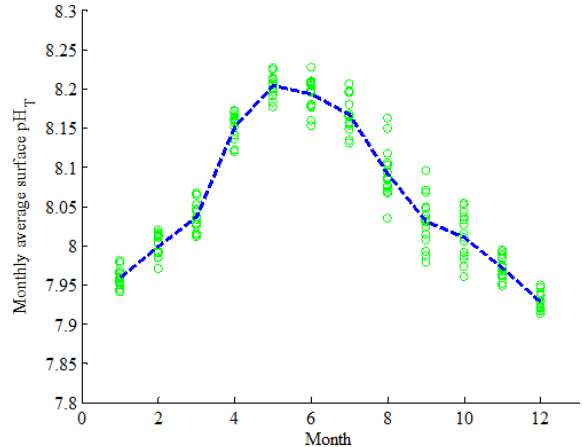
Figure 14. Seasonal cycles of surface pH T on the East China Sea shelf from 2000 to 2016. The green circles represent the monthly regional average; the dashed blue line represents the mean value of each